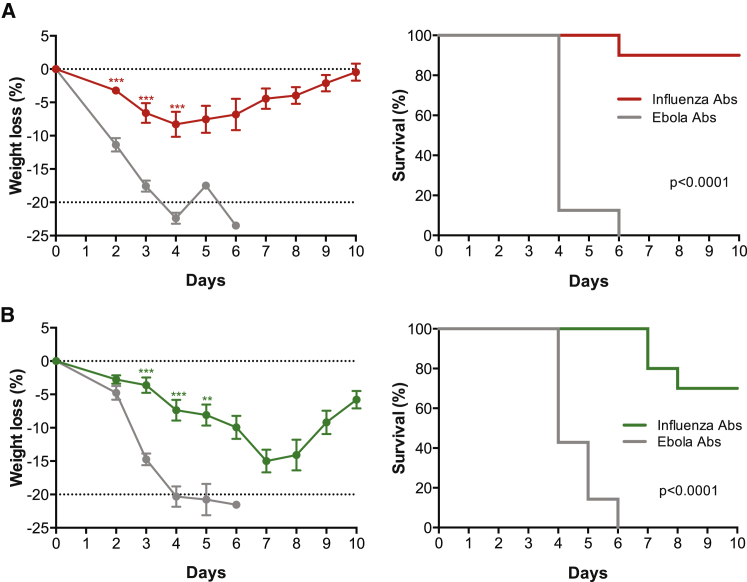
Oligoclonal mAb Response Protects Mice from Group 1 or Group 2 Influenza ChallengesBALB/c mice (n = 20) were pretreated with 20 U of hyaluronidase and administered 10 μg of H/L gWiz pDNA per anti-influenza mAb (C179, S139/1, and 9H10) in muscles of separate limbs followed by EP. For the control group, BALB/c mice (n = 15) were pretreated with 20 U of hyaluronidase and administered 10 μg of H/L gWiz pDNA per anti-Ebola mAb (2G4, 4G7, and 13C6) at distinct sites with EP. Blood was collected on days 12, 19, and 33 (in surviving mice) for pharmacokinetic analyses (Figure S5). (A and B) On day 23, the mice were randomized and anti-influenza DNA/EP mice (n = 10) and anti-Ebola DNA/EP mice (n = 7–8) were challenged with (A) 39 MLD50 of A/WSN/33 (H1N1) or (B) 21 MLD50 of A/Aichi/2/68 (H3N2) delivered intranasally. (A and B) Mean weight loss (%) ± SEM compared with day 0 (left) and survival (%) as depicted in Kaplan-Meier plots (right) following (A) H1N1 and (B) H3N2 challenge. For percent weight loss graphs, **p = 0.0021, ***p < 0.0001.